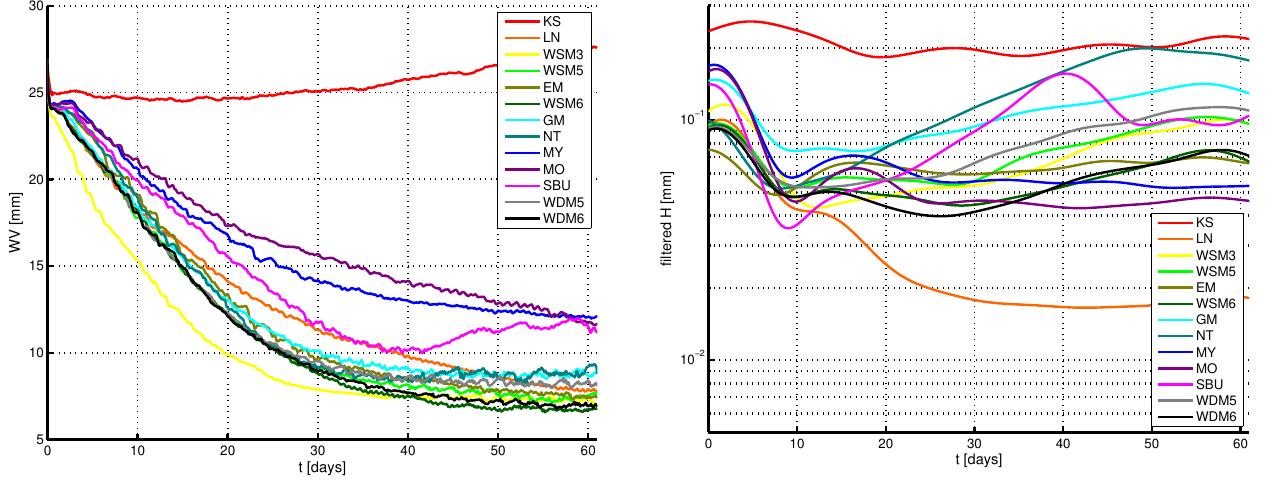
Fig. 4. Comparison of water vapour mean column density for the 13 microphysical schemes. Water vapour is depleted through its con- version into hydrometeors (Fig. 5) and accumulation at the surface under the form of precipitation (Fig. 6).